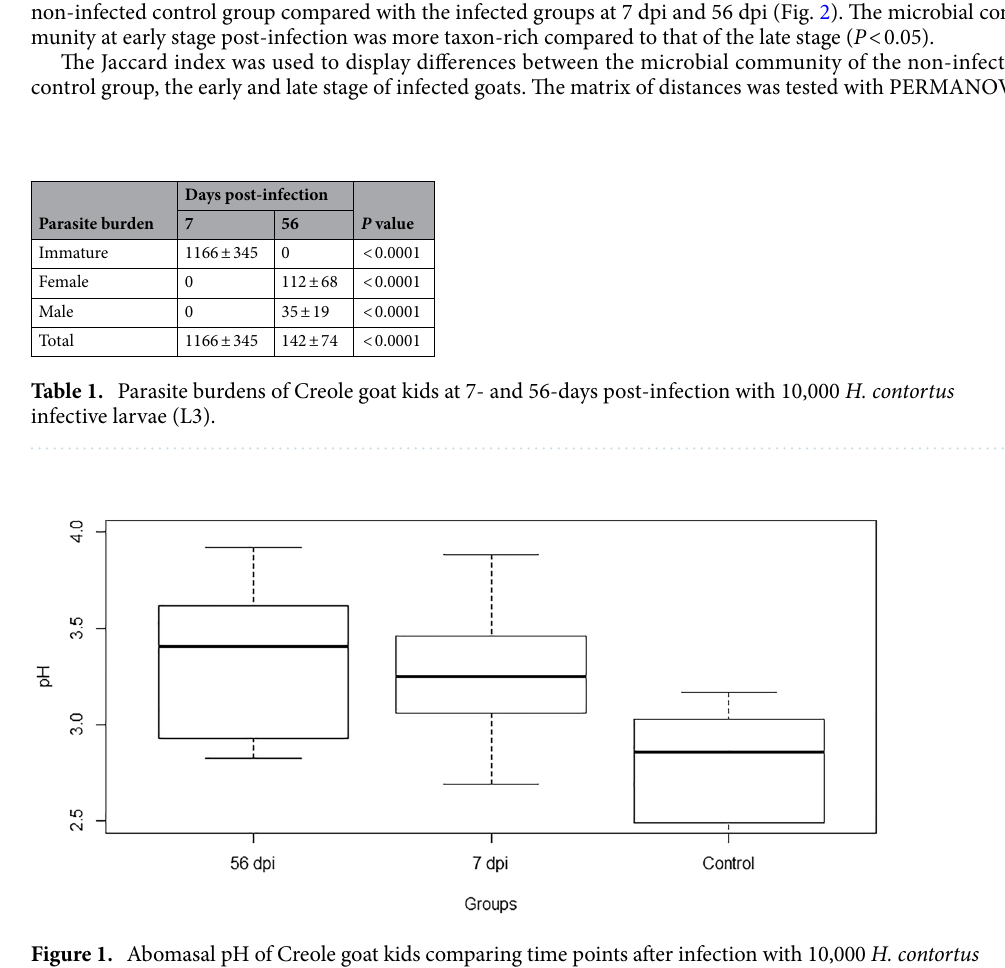
Figure 1. Abomasal pH of Creole goat kids comparing time points after infection with 10,000 H. contortus infective larvae (L3). 56 dpi (56 days post-infection), 7 dpi (7 days post-infection) and Control